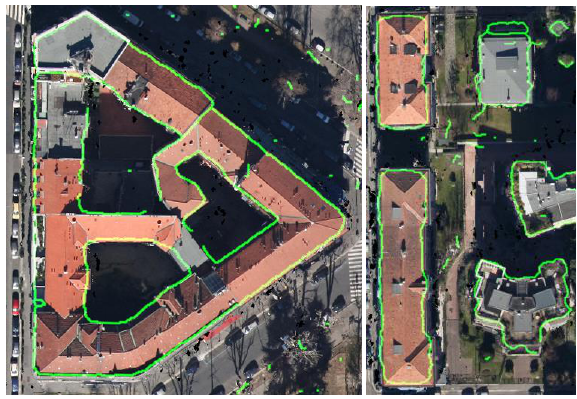
Figure 11. Examples of the extracted building footprints (skeletonized outlines) overlaid onto the true orthophoto.